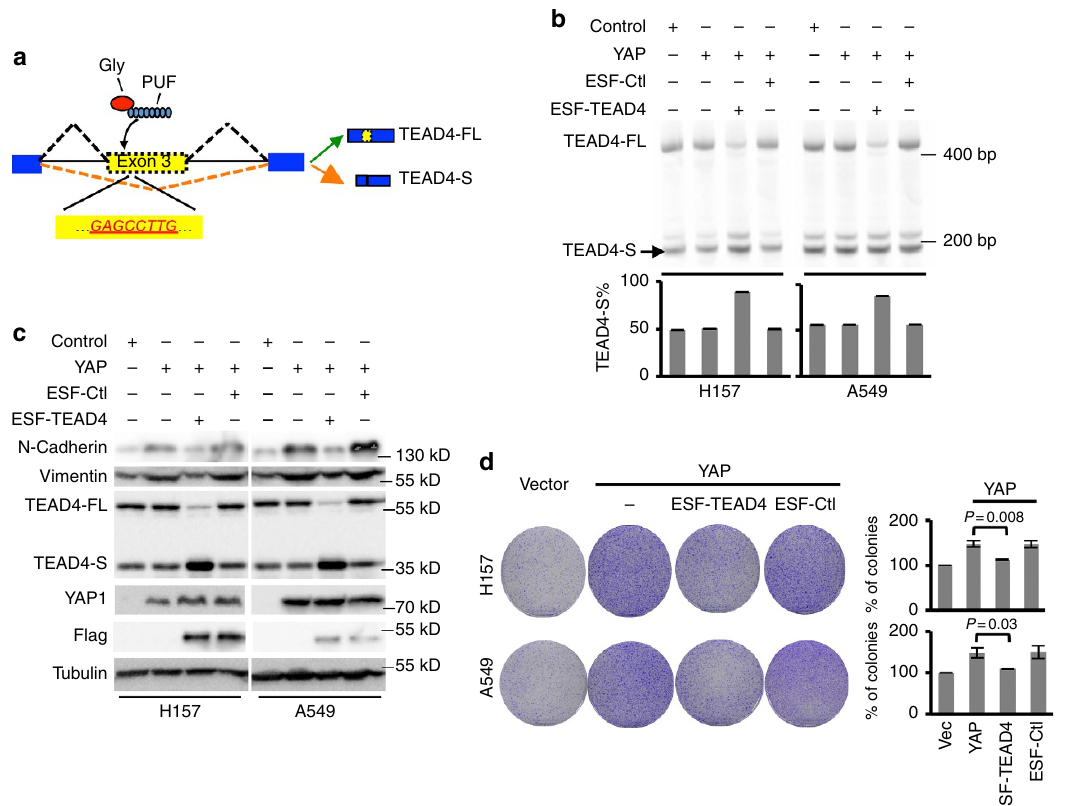
Figure 4 | The splicing switch to TEAD4-S inhibits EMTand cancer cell proliferation. ( a ) Schematics of the engineered splicing factor (ESF-TEAD4) that regulates the splicing of TEAD4. PUF domain was engineered to recognize an 8-nt RNA sequence (GAGCCTTG) in exon 3 of TEAD4, and fused with a glycine-rich motif of hnRNPA1 that can inhibit exon inclusion on binding to pre-mRNA. The resulting ESF, ESF-TEAD4, was designed to bind and inhibit the inclusion of exon 3 in TEAD4, thus inducing splicing switch towards TEAD4-S. ( b ) ESF-TEAD4 or control ESF was transfected into YAP-expressing H157 and A549 cells. RNAs were extracted from the transfected cells, and the splicing of TEAD4 was examined with RT–PCR. The representative gel was shown. The mean ± s.d. for the percentage of TEAD4-S mRNA was plotted from three experiments. ( c ) Total proteins were purified from the same set of transfected cells as in b , and the epithelial and mesenchymal markers were detected with western blots. ( d ) ESF-TEAD4 or control ESF was transfected into YAP-expressing H157 or A549 cells. Colony formation assay was carried out to examine tumour cell proliferation. All experiments were performed in triplicates, with mean ± s.d. of relative colony numbers plotted ( P values from t -test). Images of the whole plate were